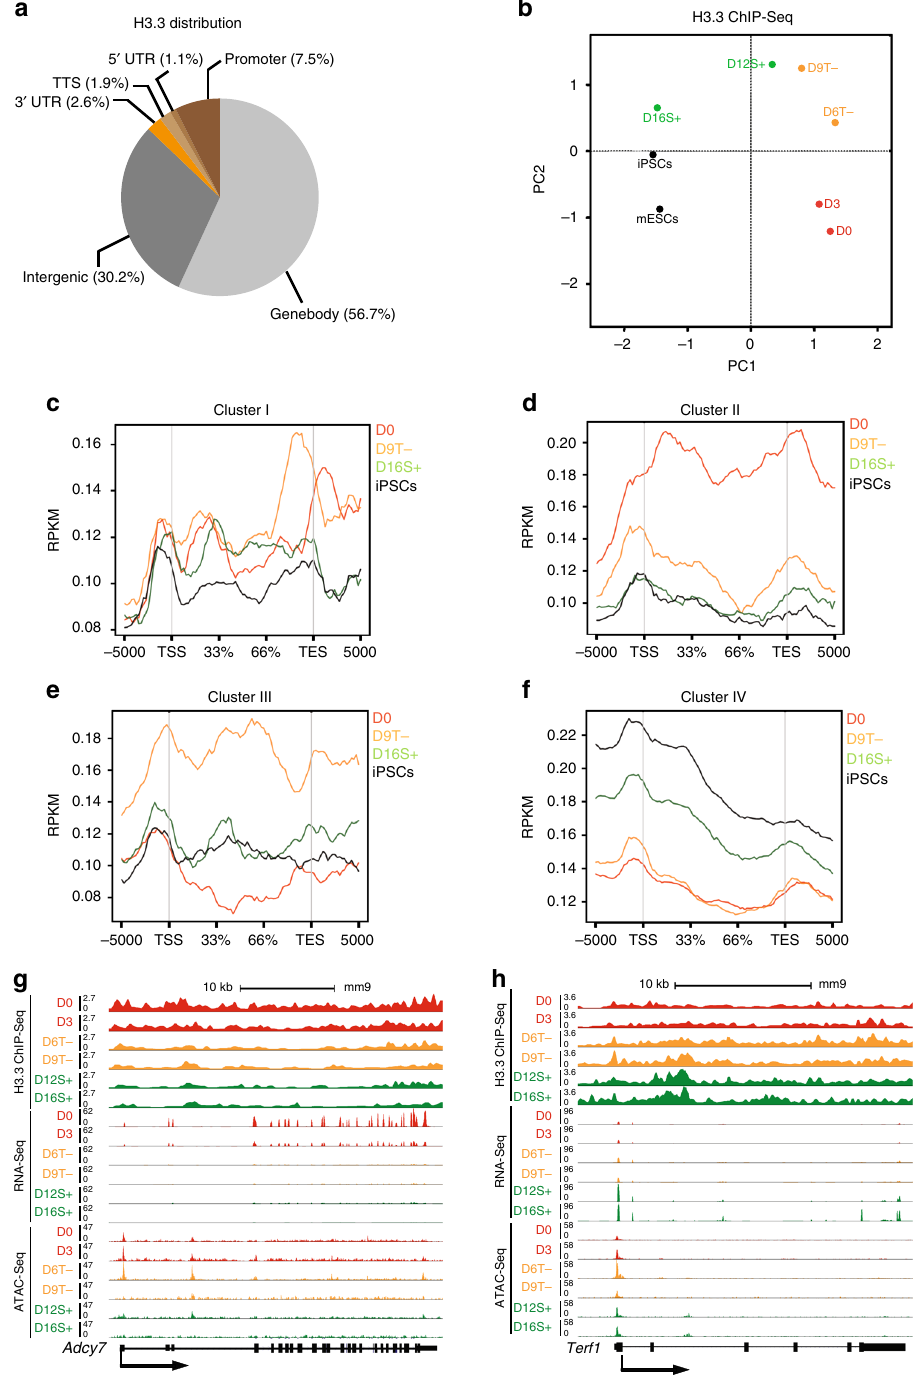
Fig. 2 Dynamic deposition of H3.3 during cellular reprogramming. a Average distribution of H3.3 peaks on the indicated genomic regions during cellular reprogramming. b PCA of H3.3 ChIP-Seq libraries at the indicated time-points. c – f Average enrichment pro fi le of H3.3 reads, belonging to the libraries at the indicated time-points, around the genebodies of Cluster I ( c ), II ( d ), III ( e ) and IV genes ( f ). The y -axis represents average normalized number of fragments mapping to the corresponding regions indicated in the x -axis. g UCSC screenshot of the dynamic chromatin accessibility, gene expression and enrichment of H3.3 on Adcy7 (Cluster I gene) during reprogramming. h UCSC screenshot demonstrating the dynamic chromatin accessibility, gene expression and enrichment of H3.3 on Terf2 (Cluster III gene) during